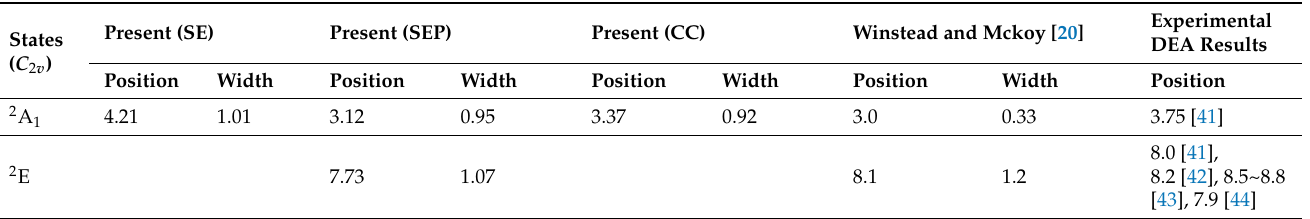
Table 2. Resonance position and widths for c -C 4 F 8 were detected in the present calculations in eV along with the comparison of Winstead and Mckoy [20] and experimental DEA [41–44]